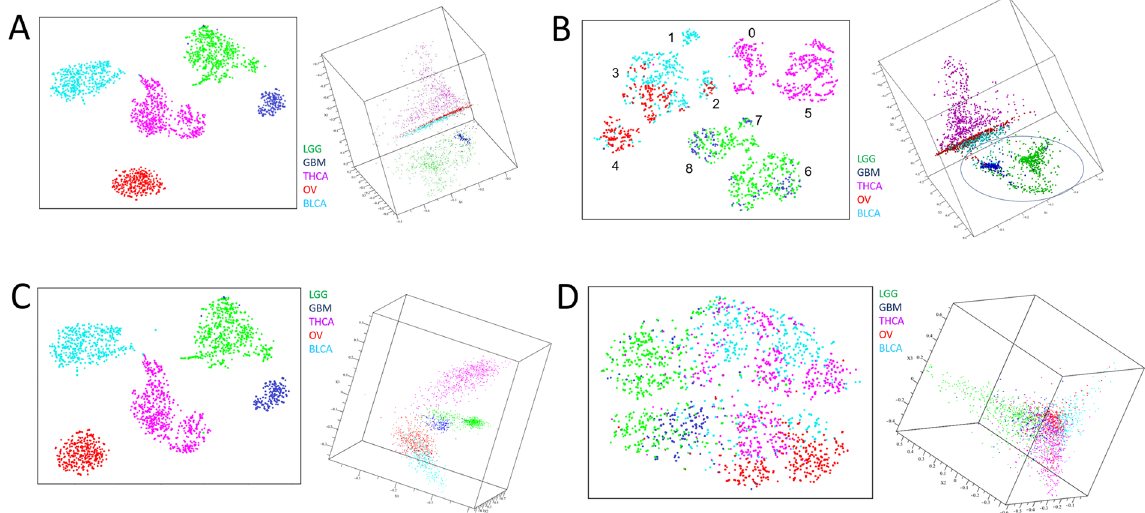
Figure 1. Tumor Classification Potential Revealed by t-Distributed Stochastic Neighbor Embedding (t-SNE) and Dynamic Quantum Clustering (DQC). Each point represents a tumor sample. ( A ) The full 2,016-tumor gene expression matrix (73,599-transcripts) embedded using t-SNE (left) or evolved by DQC (right); ( B ) The full 2,016-tumor gene expression matrix (48 “core transcripts”) embedded using t-SNE (left) or evolved by DQC (right). Numbers denote consensus clusters identified by HDBSCAN. We circled the brain tumor “arch” – discussed in the text – that is only seen in the DQC analysis; ( C ) The full 2,016-tumor gene expression matrix (all transcripts minus 48 “core transcripts”) embedded using t-SNE (left) or evolved by DQC (right); ( D ) The full 2,016-tumor gene expression matrix (48 random transcripts) embedded using t-SNE (left) or evolved by DQC (right). Full DQC animation of 48 “core transcripts” can be seen in Supplemental Video